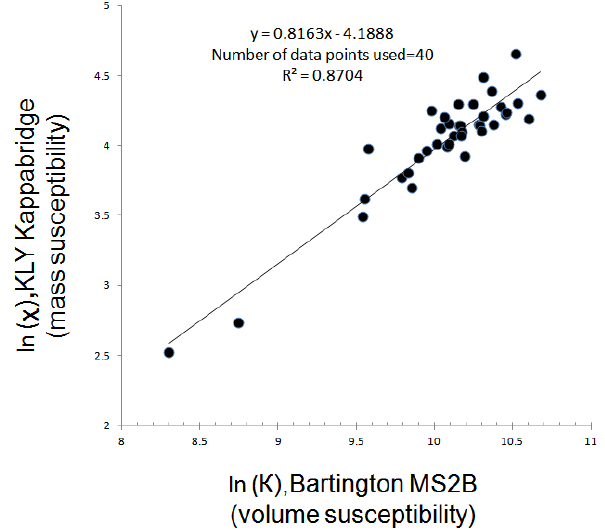
Fig.3 – Calibration curves for the calculation of mass specific susceptibility values (10 –8 m 3 kg –1 ) 18 Fig. 3. Calibration curves for the calculation of mass specific sus- from the volume specific measurements. 19 ceptibility values (10 − 8 m 3 kg − 1 ) from the volume specific mea- surements.